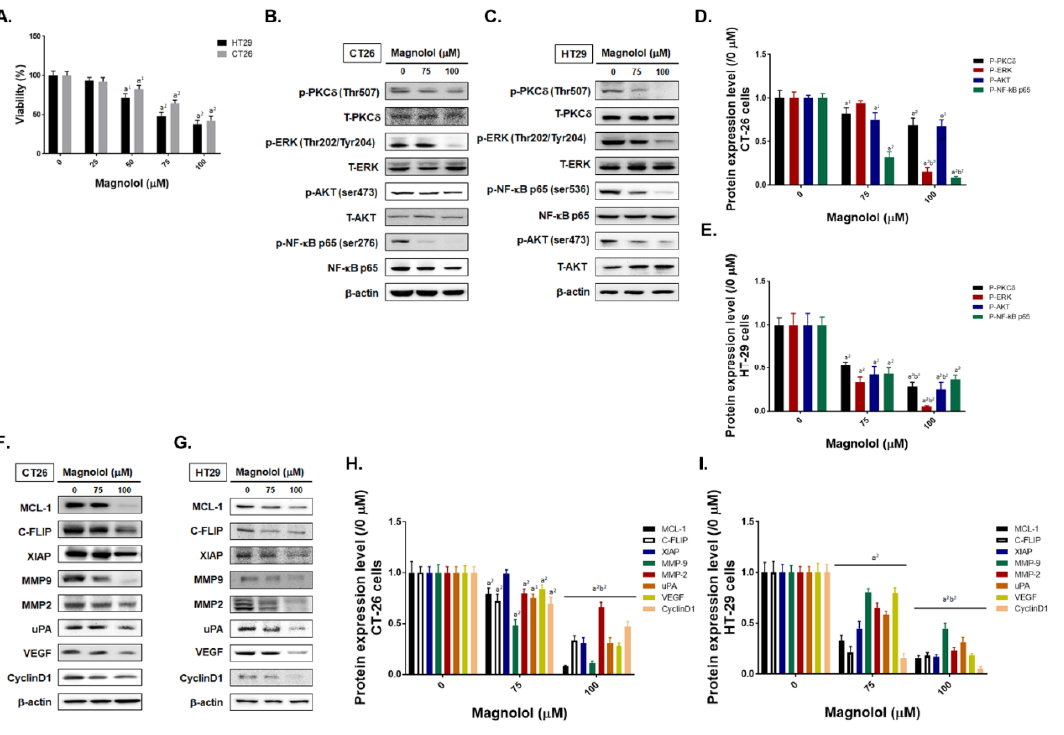
Figure 2. The viability, the phosphorylation of PKC δ /ERK/AKT/NF- κ B and the expression of NF- κ B mediated downstream proteins is suppressed by magnolol in CRC cells. ( A ) MTT assay result of magnolol is presented. Western blotting and three repeated PKC δ , ERK, AKT, NF- κ B protein expression average level bar chart in ( B ) CT26 and ( C ) HT29 after magnolol treatment are displayed. ( D,E,H,I ) Repeated experiment of protein expression level is calculated and presented. Western blotting results of NF- κ B mediated downstream proteins on ( F ) CT26 and ( G ) HT29 after magnolol treatment is shown. (a 2 p < 0.01 vs 0 μ M magnolol; b 2 p < 0.01 vs 75 μ M magnolol).